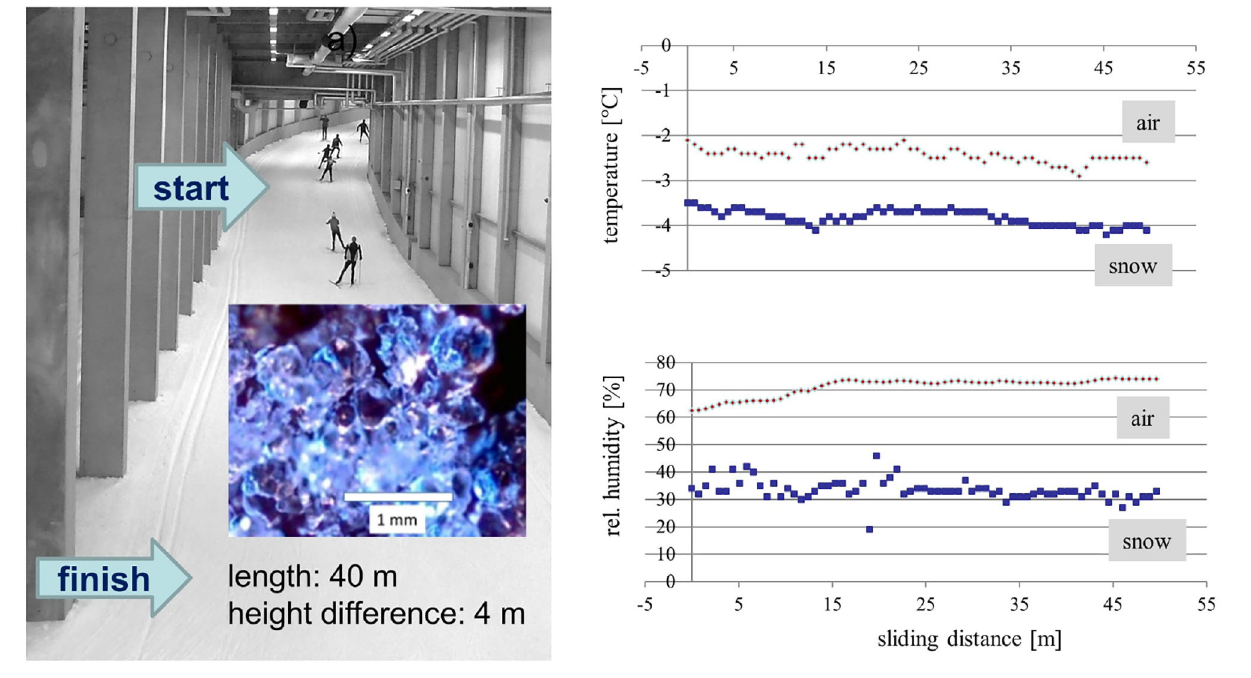
FIGURE 1 | Sliding test in the skitunnel in Oberhof. The sliding distance was 40 m with a difference in height of 4 m. The insets show snow outside of a track as well as the course of temperatures and relative humidities along the sliding